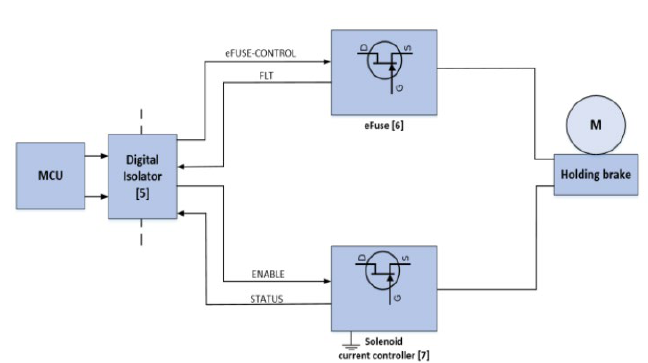
Figure 5. Block diagram of SBC function